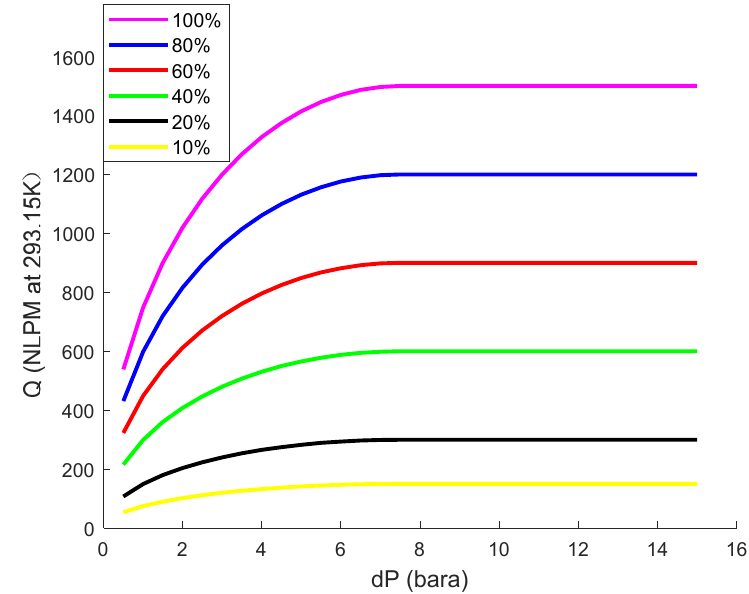
Figure 3. Hydrogen flow rate characteristics of the proportional valve.